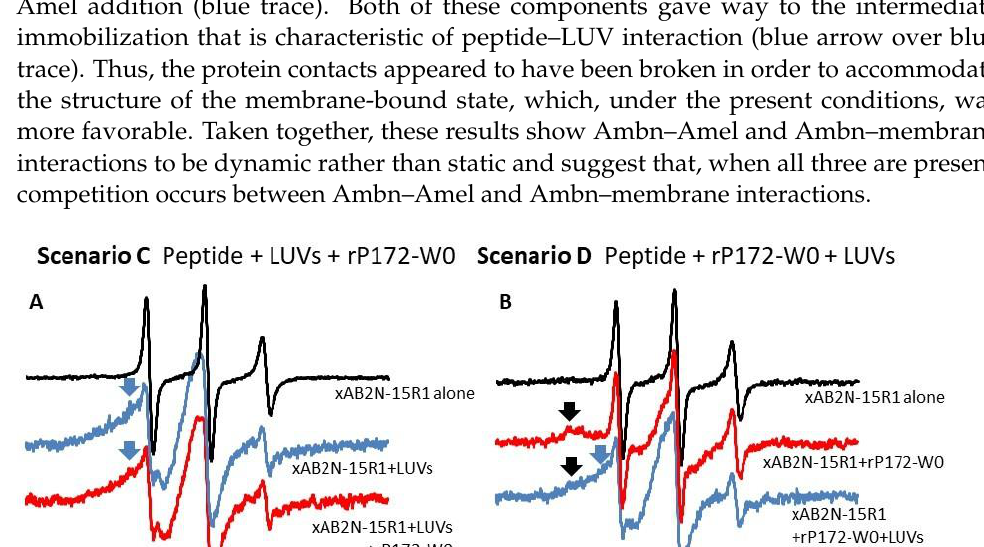
a 1:1 ratio with xAB2N-15R1 (Figure 9A, red trace), indicating that little protein binding